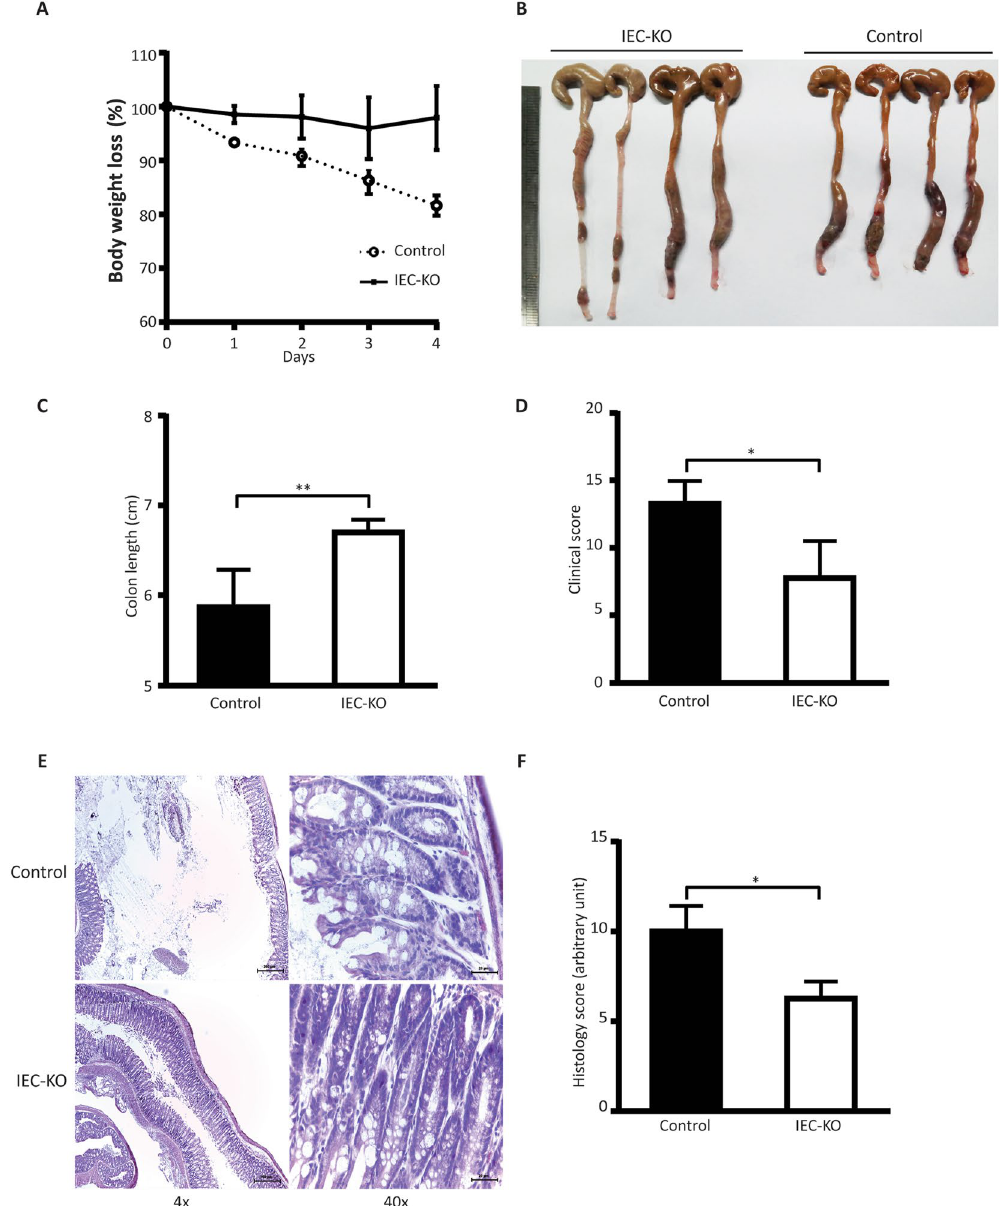
Figure 2. Intestinal epithelial-specific PLD2 deletion protects mice from the development of dinitrobenzene sulphonic acid (DNBS)-induced colitis. ( A ) Body weight change in control and IEC-KO mice after treatment with DNBS. Mice were given a single intra-rectal administration of 200 mg/kg DNBS in 35% ethanol, and body weight was measured every day. ( B ) Gross imaging of the colons after treatment with DNBS in control and IEC-KO mice. ( C ) Colon length in the control and IEC-KO mice after treatment with DNBS for 4 days. ( D ) Clinical score of the control and IEC-KO mice after DNBS treatment. ( E ) H&E staining of the colon tissue from the control and IEC-KO mice. ( F ) Histological scoring in control and IEC-KO mice after challenge with DNBS. Scale bar: 200 µ m, 20 µ m. All data are shown as mean ± SEM. * p < 0.05, ** p <